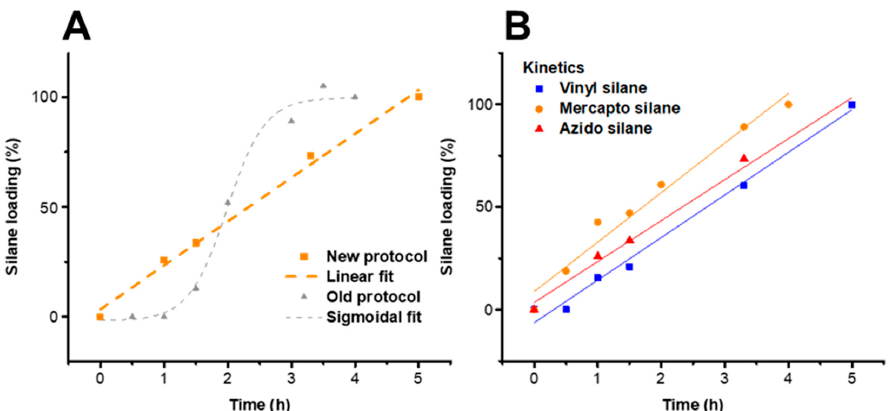
Figure 5. ( A ) Comparison of silanization kinetics of cellulose II gel with 3-azidopropyl triethoxysilane